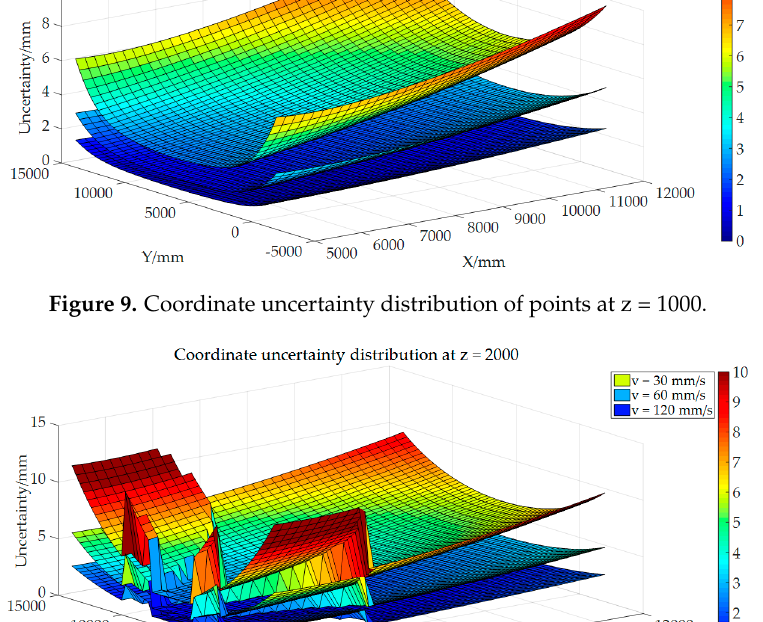
Figure 10. Coordinate uncertainty distribution of points at z = 2000.